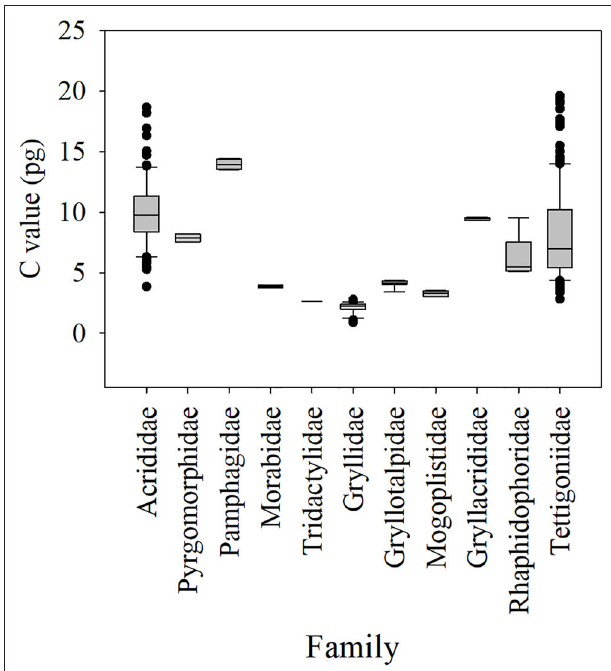
FIGURE 1 | Boxplot of genome sizes for families of Orthoptera, including data from the present study and the Animal Genome Size Database ( Gregory, 2020 ).